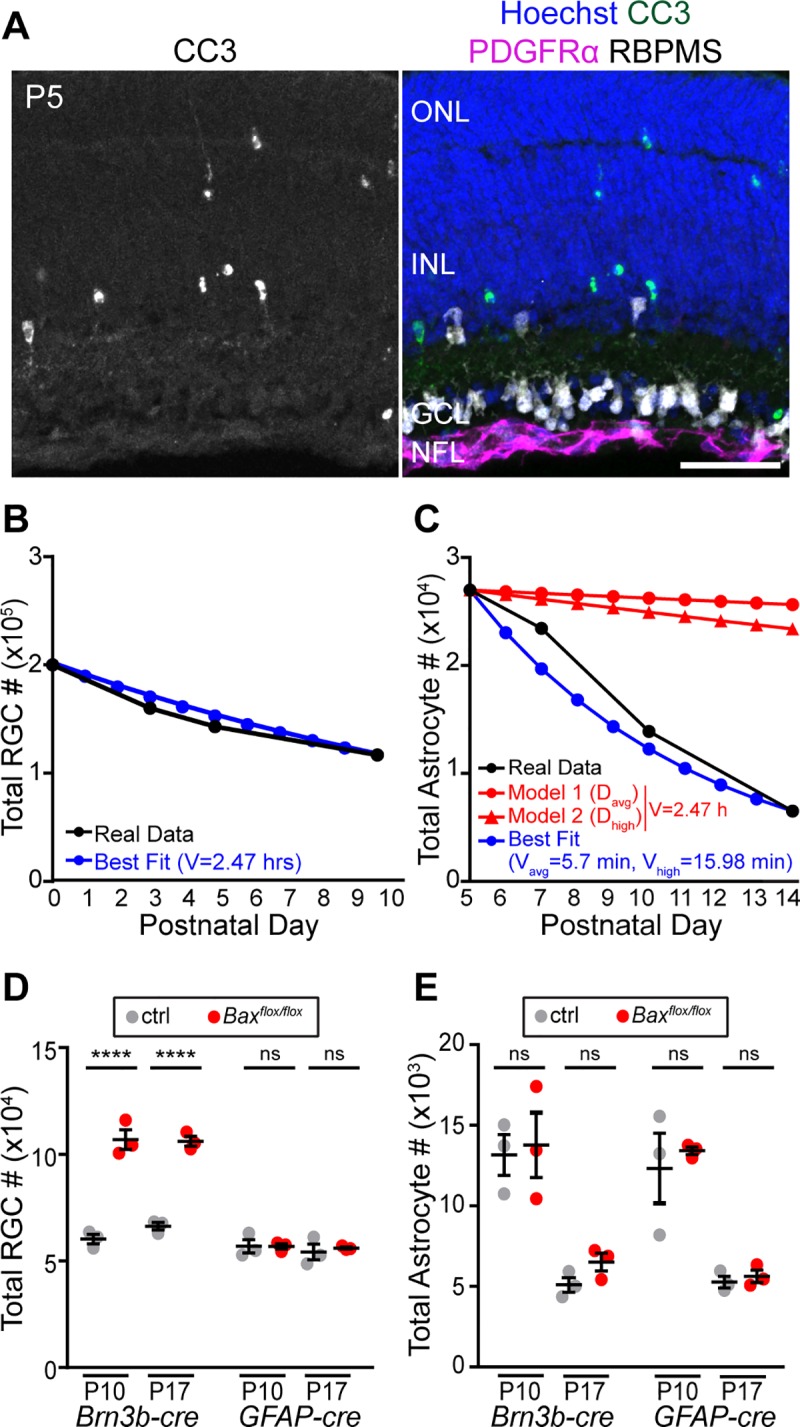
Retinal astrocyte loss is not due to apoptosis.(A) P5 retinal sections stained for CC3 (apoptosis marker), PDGFRα (astrocyte marker), RBPMS (RGC marker), and Hoechst (nuclear stain). CC3+ cells are frequently found in neuronal layers but not in the RNFL, where astrocytes reside. (B,C) Modeling to determine the effect of observed apoptosis rate on RGC (B) and astrocyte (C) population size. Black, observed cell number (B, RGC data from [35], see also S3D Fig; C, astrocyte numbers from Fig 1G). Blue, best fit models using observed apoptotic cell fraction as death rate parameter. Apoptotic RGC fraction (B) from [35] (see also S3D Fig). For astrocytes (C), both average (Davg) and maximum (Dhigh) CC3+ astrocyte fractions from S3C Fig were used. Clearance time parameter V in the best fit model is given. Red in (C): astrocyte model with the clearance time parameter set to a biologically plausible value (2.47 hours); death rate set either to Davg (circles) or Dhigh (triangles) (see S3C Fig). Apoptosis alone cannot account for the observed astrocyte numbers. (D,E) Effects of cell type–specific Bax deletion on RGC (D) and astrocyte (E) numbers. RGCs, Brn3b-Cre; astrocytes, GFAP-Cre. Statistics: for each cell type, three-way ANOVA followed by Tukey post hoc test (see S1 Table for ANOVA details); ****p < 0.0001. NS p-values ≥ 0.99. N = 3 for all groups. Error bars: mean ± SEM. Sample sizes depicted by data points on graph. For data plotted in graphs, see S1 Data. Scale bar, 50 μm. CC3, cleaved-caspase 3; ctrl, control; GCL, ganglion cell layer; INL, inner nuclear layer; NFL, nerve fiber layer; NS, not significant; ONL, outer nuclear layer; PDGFR, platelet-derived growth factor receptor; RGC, retinal ganglion cell; RNFL, retinal nerve fiber layer.